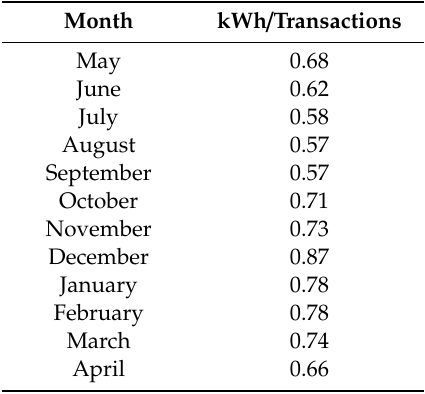
Table 1. Summary of energy consumption per